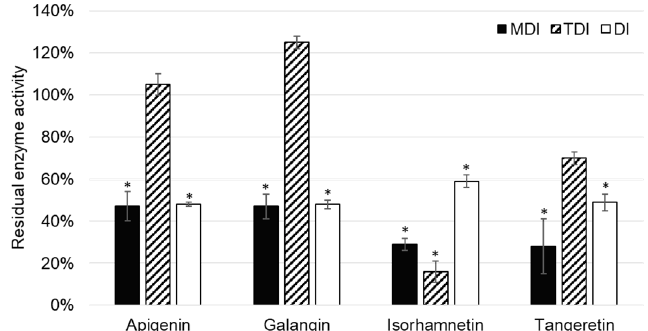
Figure 4. Residual CYP2A6 enzyme activity after incubation with 1 µM flavonoid in the experiments for the determination of metabolism dependent inhibition (MDI), time dependent inhibition (TDI), and direct inhibition (DI). * denotes that observed inhibition is statistically significant ( p < 0.05) when compared to the control (without addition of flavonoid).